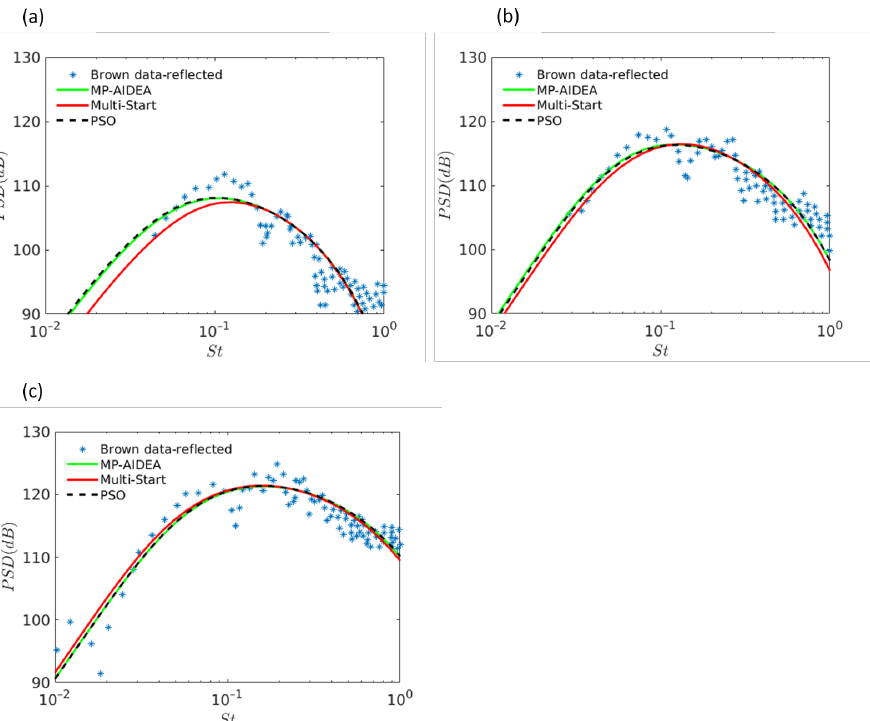
Figure 10. Comparison of acoustic predictions using different optimization routines for method 1 ( a ) Ma = 0.5 ( b ) Ma = 0.7 ( c ) Ma =